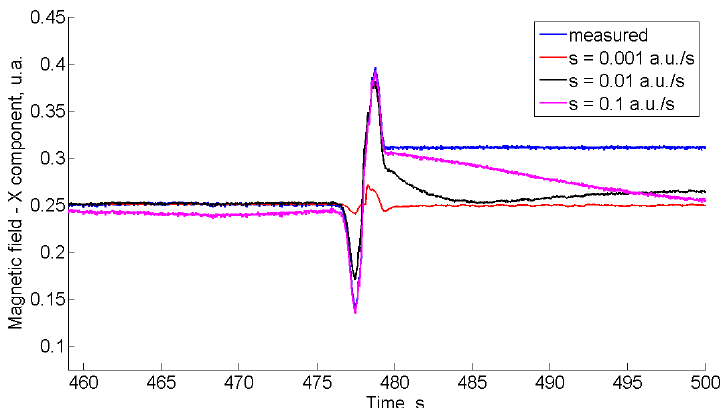
Figure 3. The time function of the X -component of the magnetic field, estimated by the . In blue the time function of the measured X -component of the magnetic field EKF-M A (see